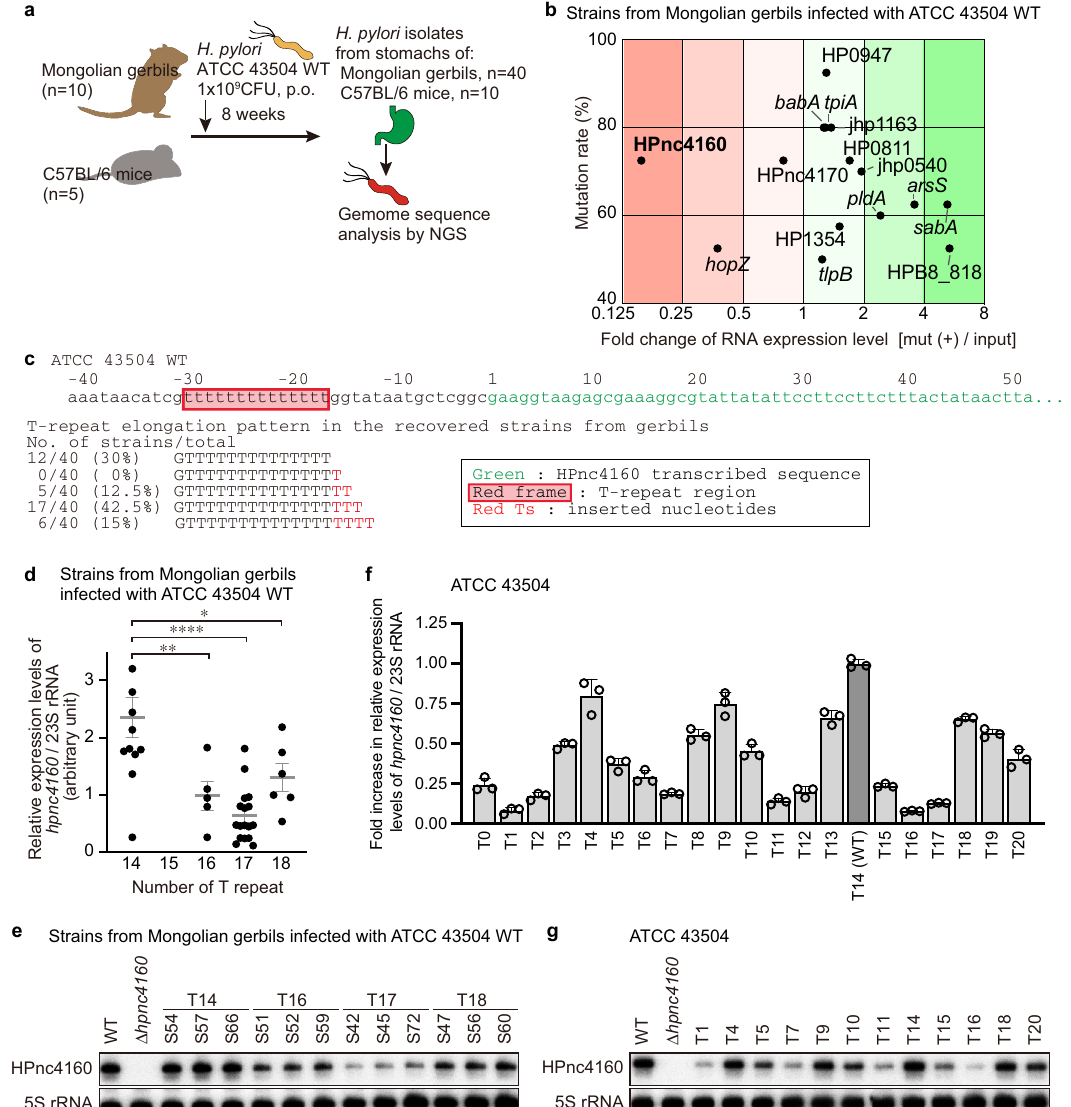
Fig. 1 H. pylori acquires T-repeat extension upstream of HPnc4160 to decrease its expression during infection in vivo. a Schematic showing experimental strategy. b RNA expression levels of ORFs or nearby genes of genome regions mutated in >50% of the strains recovered from gerbils, plotted against mutation rates. c DNA sequence around the HPnc4160 and T-repeat sequence of the strains recovered from gerbils. d – g Relative hpnc4160 expression in H. pylori strains recovered from gerbils (T repeat number of 14, n = 12; 16, n = 5; 17, n = 17; 18, n = 6) and genetically modi fi ed T-repeat lengths ( n = 3) in RT-PCR ( d , f ) and Northern blot ( e , g ). Shown are the means ± s.d ( d , f ). Data were processed by Grubbs ’ test for outliers. * P = 0.0379, ** P = 0.0088, **** P < 0.0001 by Sidak ’ s multiple comparison tests (two sided) ( d ). Data are representative of two independent experiments ( d – g ). Source data are provided as a Source Data fi